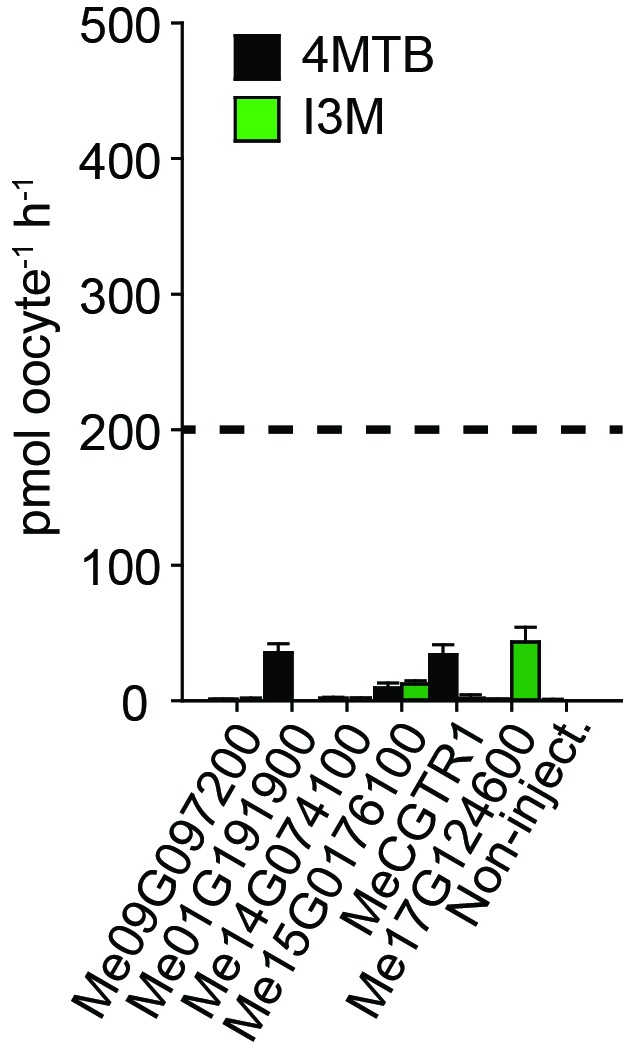
Accumulation of 4MTB and I3M in X. laevis oocytes expressing close M. esculenta homologs of Me14G074000.Genes were expressed individually in X. laevis oocytes and transport activity was measured in the presence of 0.2 mM 4MTB (black bars) or 0.2 mM I3M (green bars). Accumulated 4MTB or I3M was quantified by LC-MS in 5 × 1 oocytes for each gene (Error bars represent ± s.d. of mean for data obtained from five different oocytes per experiment, experiment repeated two times). Dotted line represents media substrate concentration.